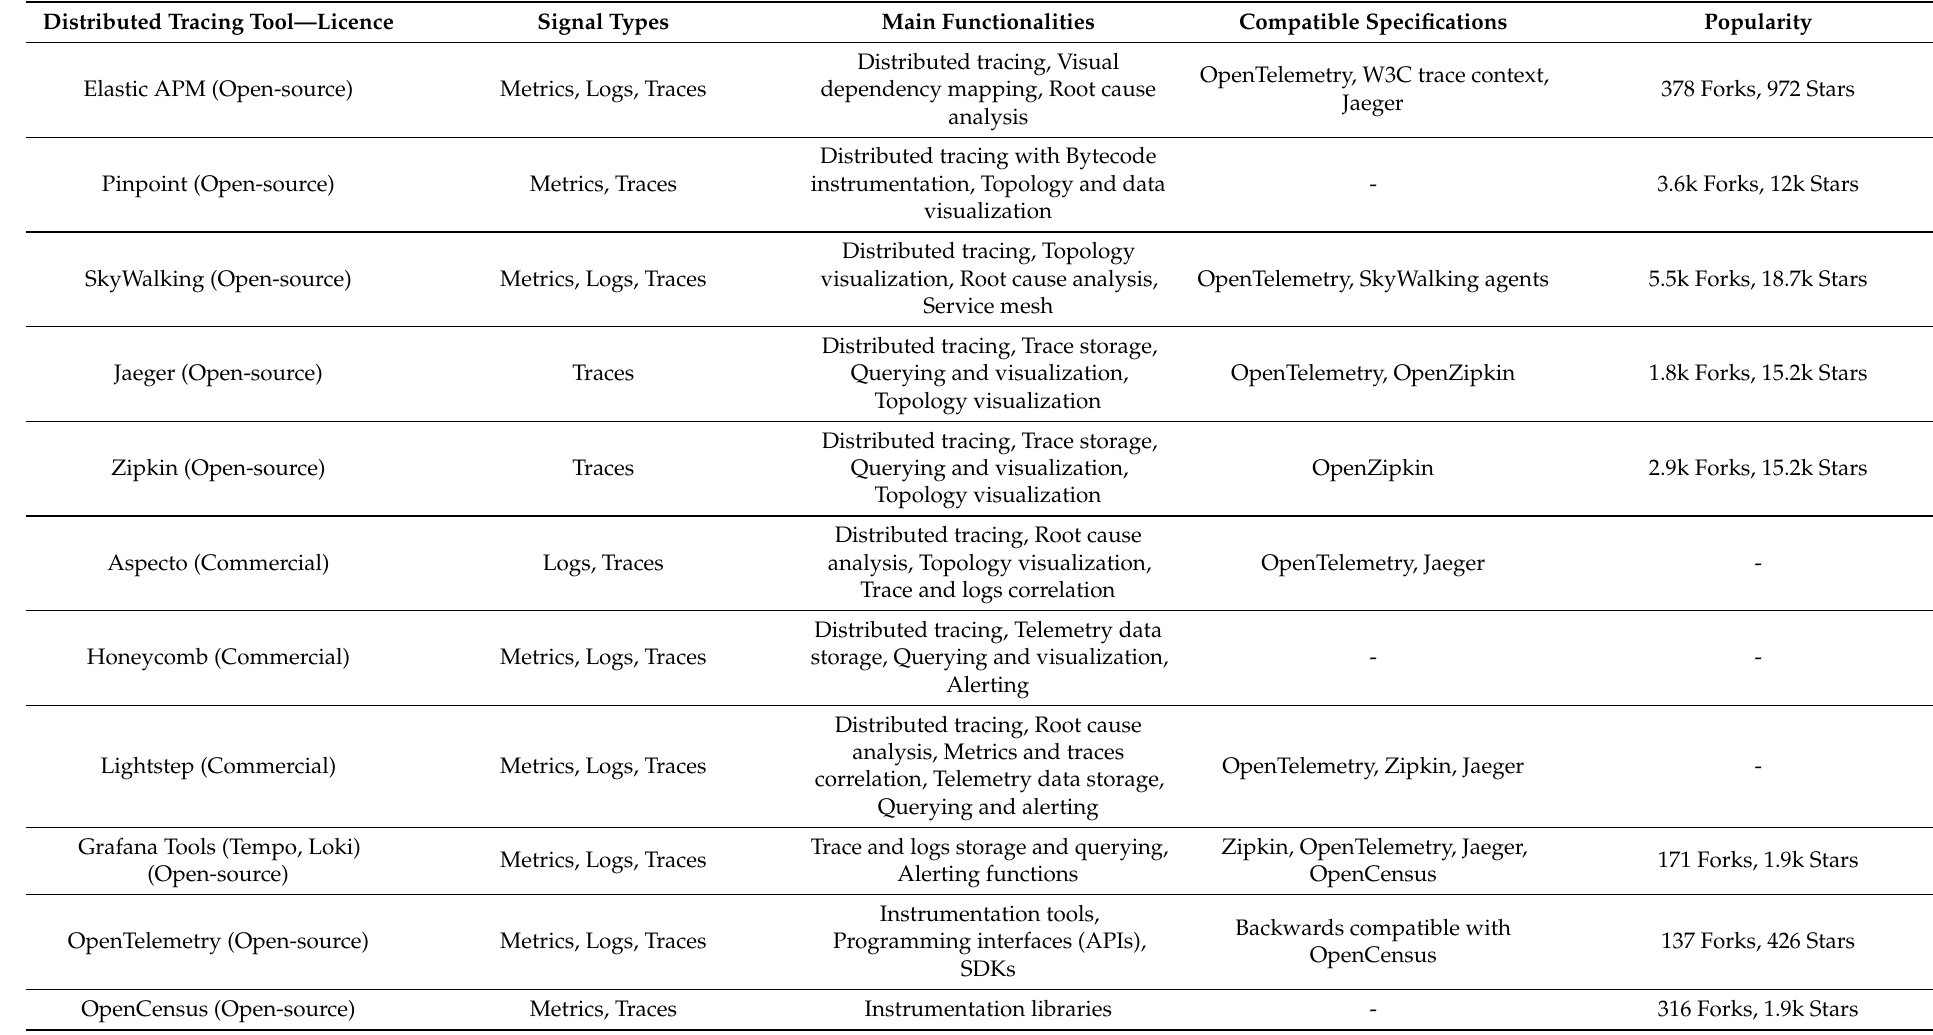
Table 1. Distributed tracing tools